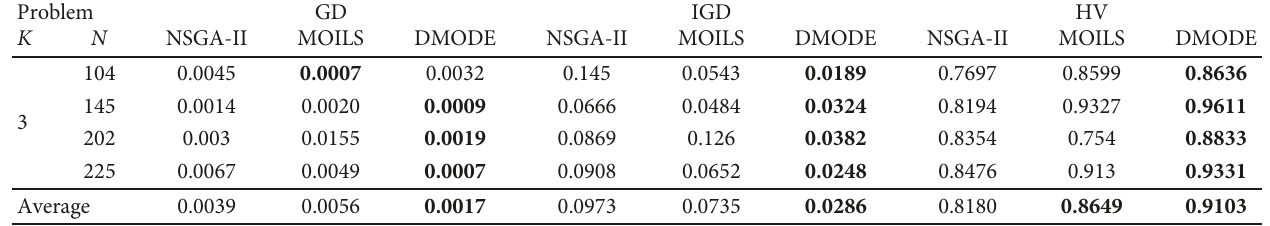
Table 4: Performance metrics obtained by NSGA-II, MOILS, and DMODE for practical problems. Problem GD IGD